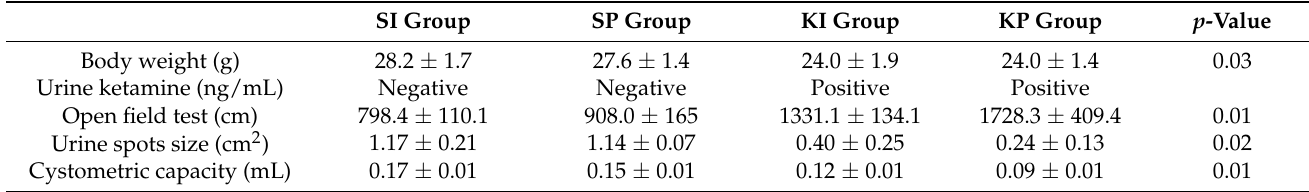
Figure 6. Ketamine inhalation and histological changes. Denuded urothelium (arrows) with sub- costal edema were observed only in KI and KP mice but not in SI and SP mice. Table 1. Summary of the